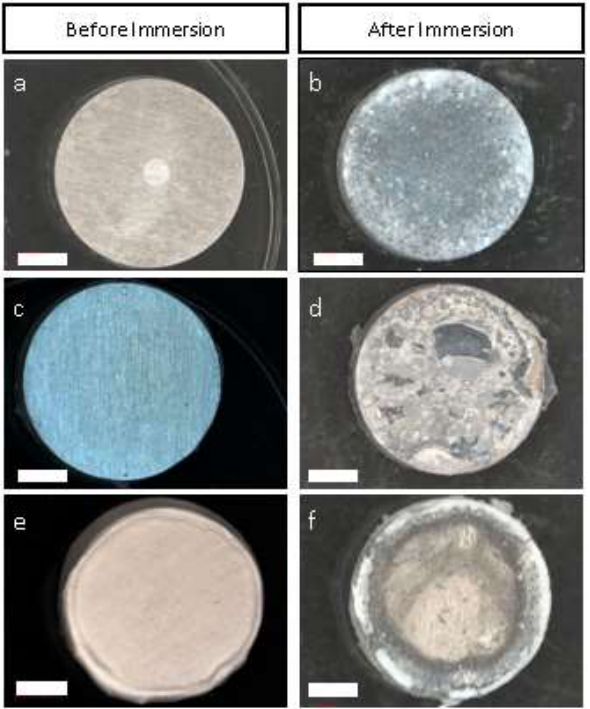
Figure 4. Light microscopy pictures of the surface of the samples before and after immersion in rSBF: ( a ) uncoated (MgUc) before immersion; ( b ) uncoated (MgUc) after immersion; ( c ) spin-coated magnesium (MgSc) before immersion; ( d ) spin-coated magnesium (MgSc) after immersion; ( e ) surface appearance of electrospun fiber-coated magnesium (MgFc) before immersion; ( f ) and after immersion (removed fiber coating) (white scale bar = 2 mm).